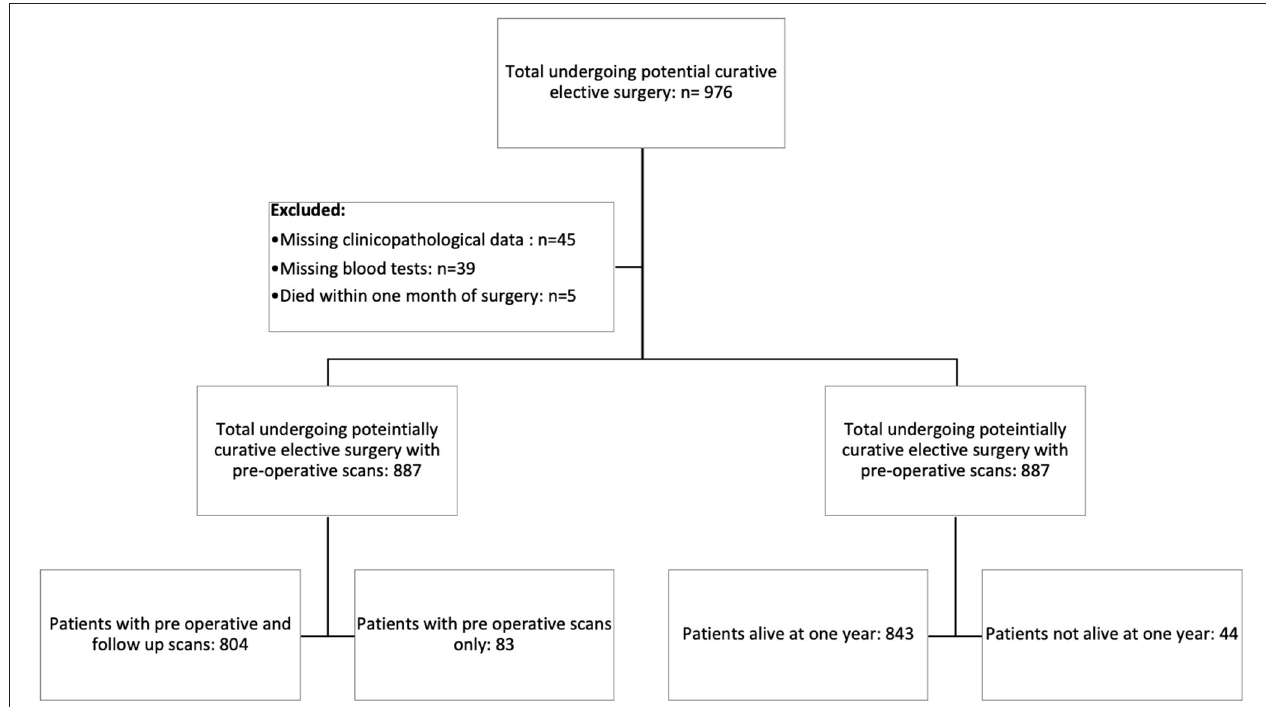
FIGURE 1 | Prisma diagram of patients excluded from the study due to missing clinicopathological data, blood tests, or death within 1 month of surgery. Further subdivisions showing the number of patients with follow-up scans at 1 year and patients alive at 1 year.